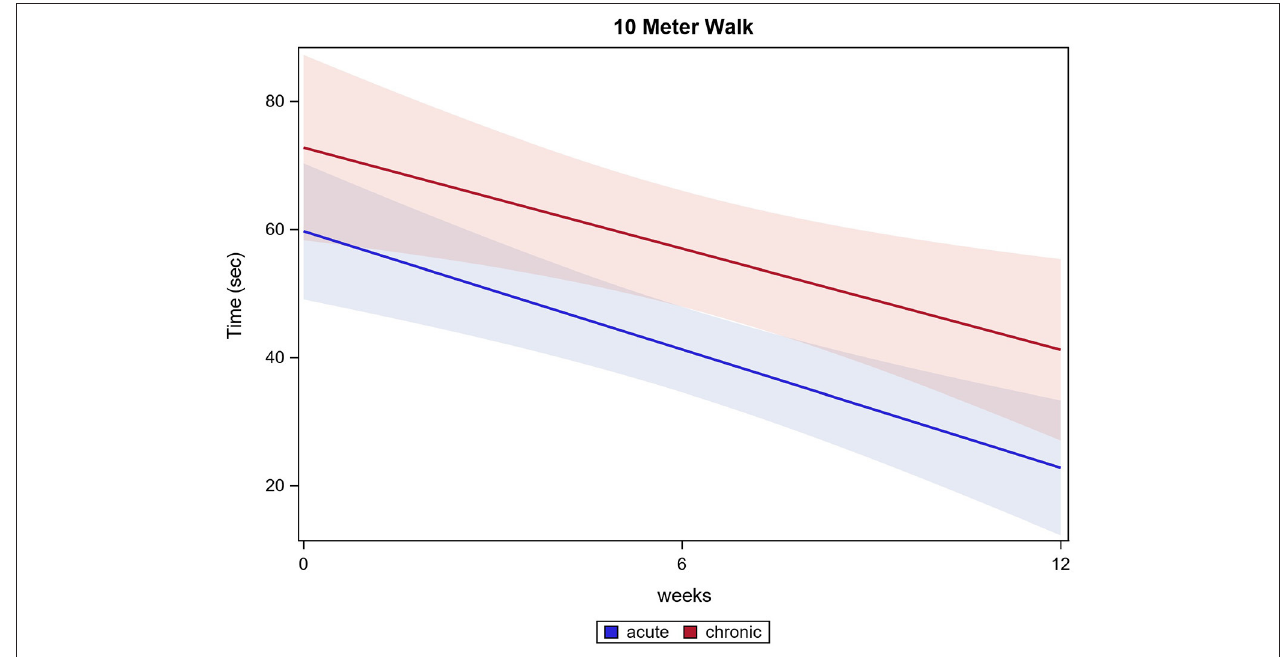
FIGURE 1 | Ten meter